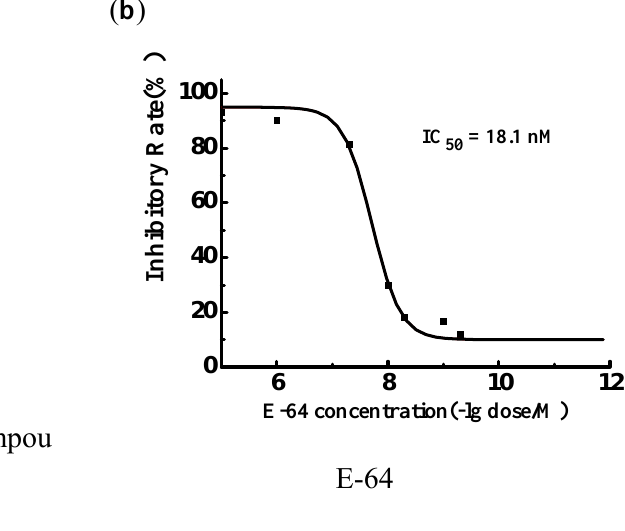
Figure 1 . Concentration dependence of inhibitory activity by 1 and E-64, the concentration of FP-2 was kept constant at 30 nM while the concentration of compounds ranged from 0.001 to10 μ